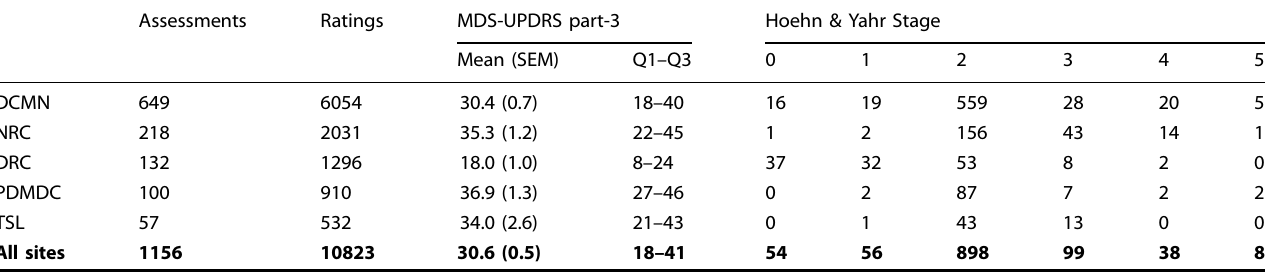
Table 1. Summary of the MDS-UPDRS assessment dataset.